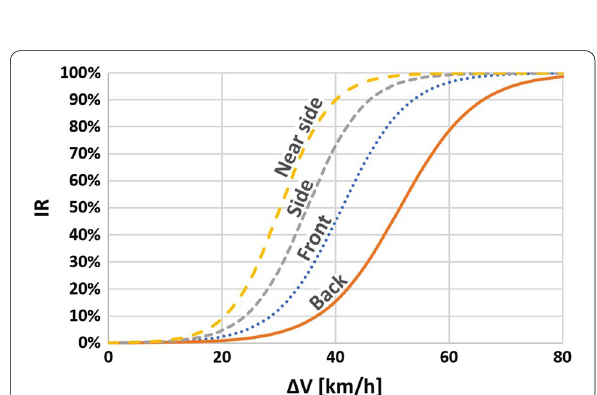
Fig. 4 Example model where IR is a function of (cid:31) V , impact zone and position of the occupant